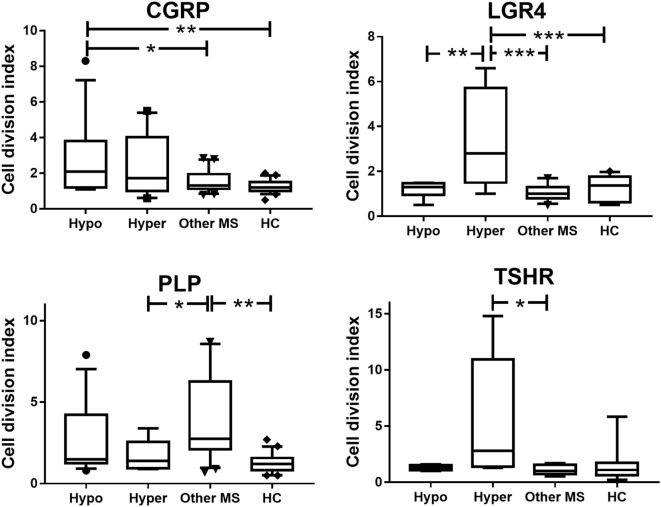
Proliferative responses to calcitonin gene-related peptide (CGRP), LGR4, thyroid-stimulating hormone receptor (TSHR), and proteolipid protein (PLP) in patients with coexisting CNS demyelinating disease and autoimmune hypothyroidism (Hypo) or hyperthyroidism (Hyper), multiple sclerosis (MS) alone, or healthy controls (HC). Because the data are not normally distributed, they were analyzed used the Kruskal–Wallis test (non-parametric equivalent of ANOVA), with Dunn’s multiple comparisons test to allow for multiple comparisons being made in the figure. The box of the box and whisker plots extends from the 25th to the 75th percentiles of the results. The line in the middle of the box is plotted at the median. The whiskers are drawn down to the 10th percentile and up to the 90th. Points below and above the whiskers are drawn as individual points. *p < 0.05 and **p < 0.001, compared to the indicated groups.